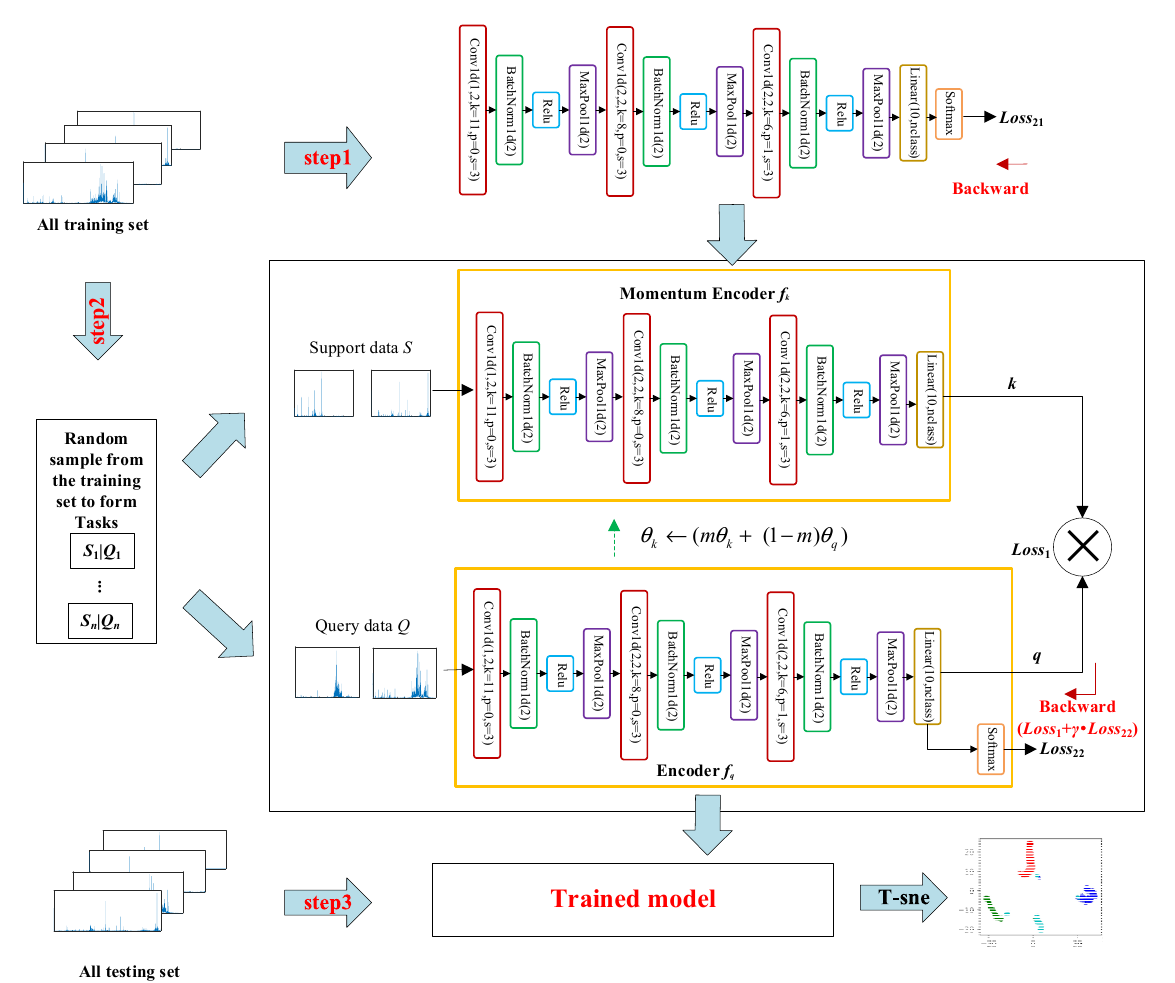
Figure 2. Model structure of MA-MOCO for wind turbines one-shot learning.